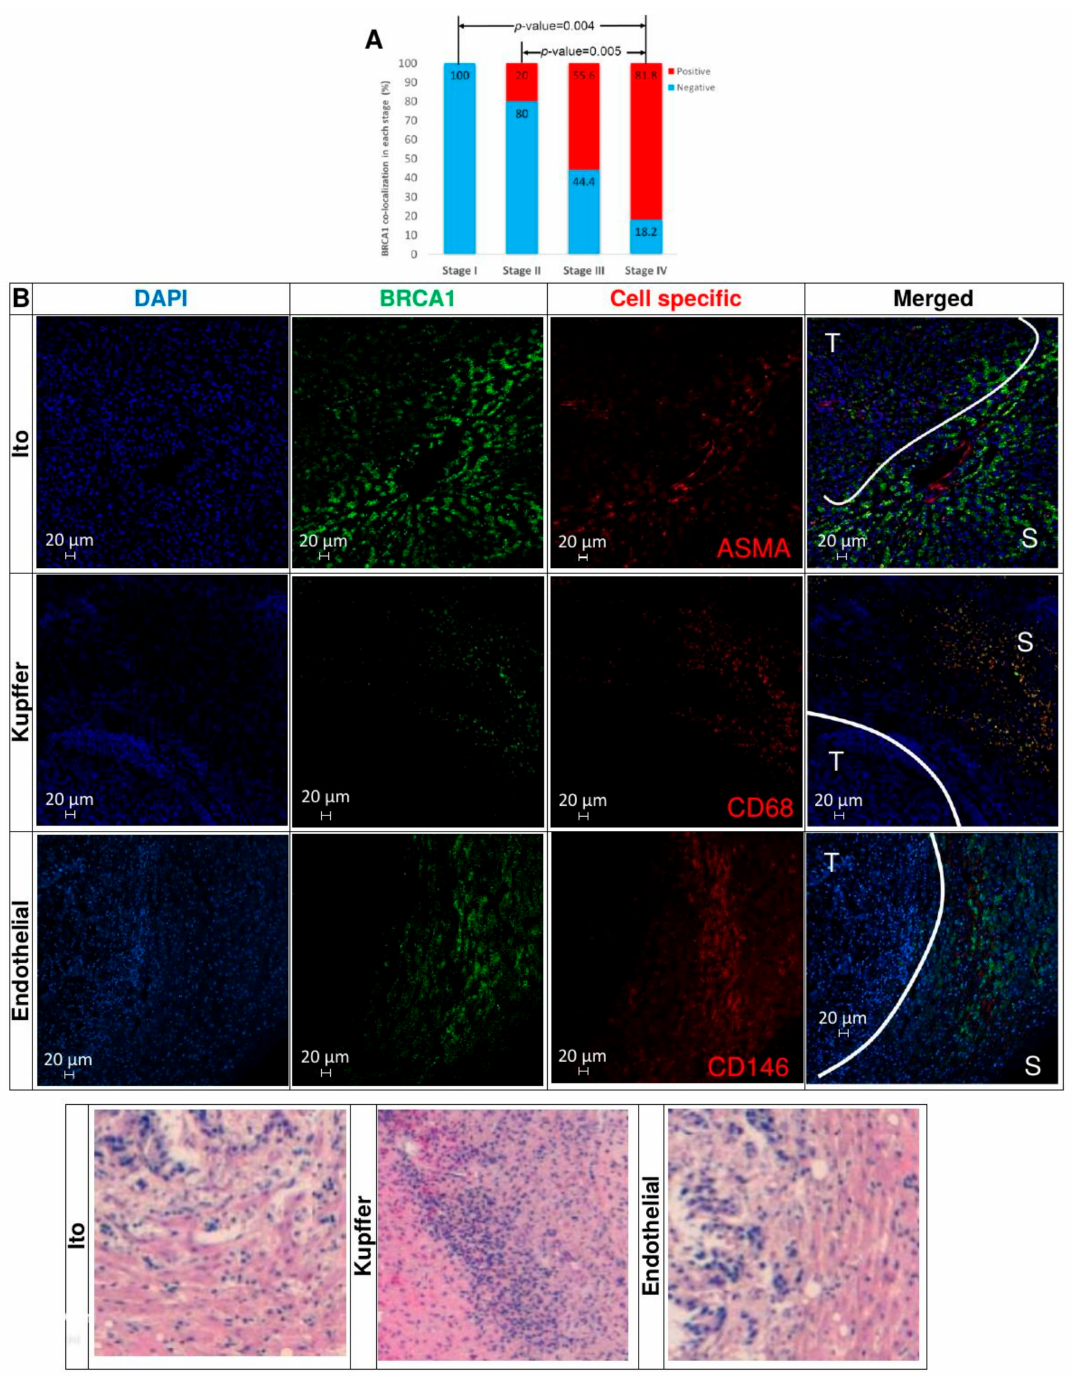
Figure 7. BRCA1 co-localization in TME cells from human CRC liver metastases. ( A ) The percentage of simultaneous BRCA1 expression in endothelial, Ito, and Kup ff er cells significantly increases in metastases from Stage IV tumors (synchronous) compared to Stage I and II ones (metachronous). Positive = Co-expression of BRCA1 protein in the three TME cell types. Negative = No expression of BRCA1 in any TME cell type. ( B ) BRCA1 expression is co-localized on Ito, Kup ff er, and endothelial cells from liver metastases from CRC categorized as Stage IV at first diagnosis (synchronous). White lines delimit the tumor cell tissue regions (T) from the non-tumoral cell stromal area (S). The last row shows the hematoxylin and eosin staining